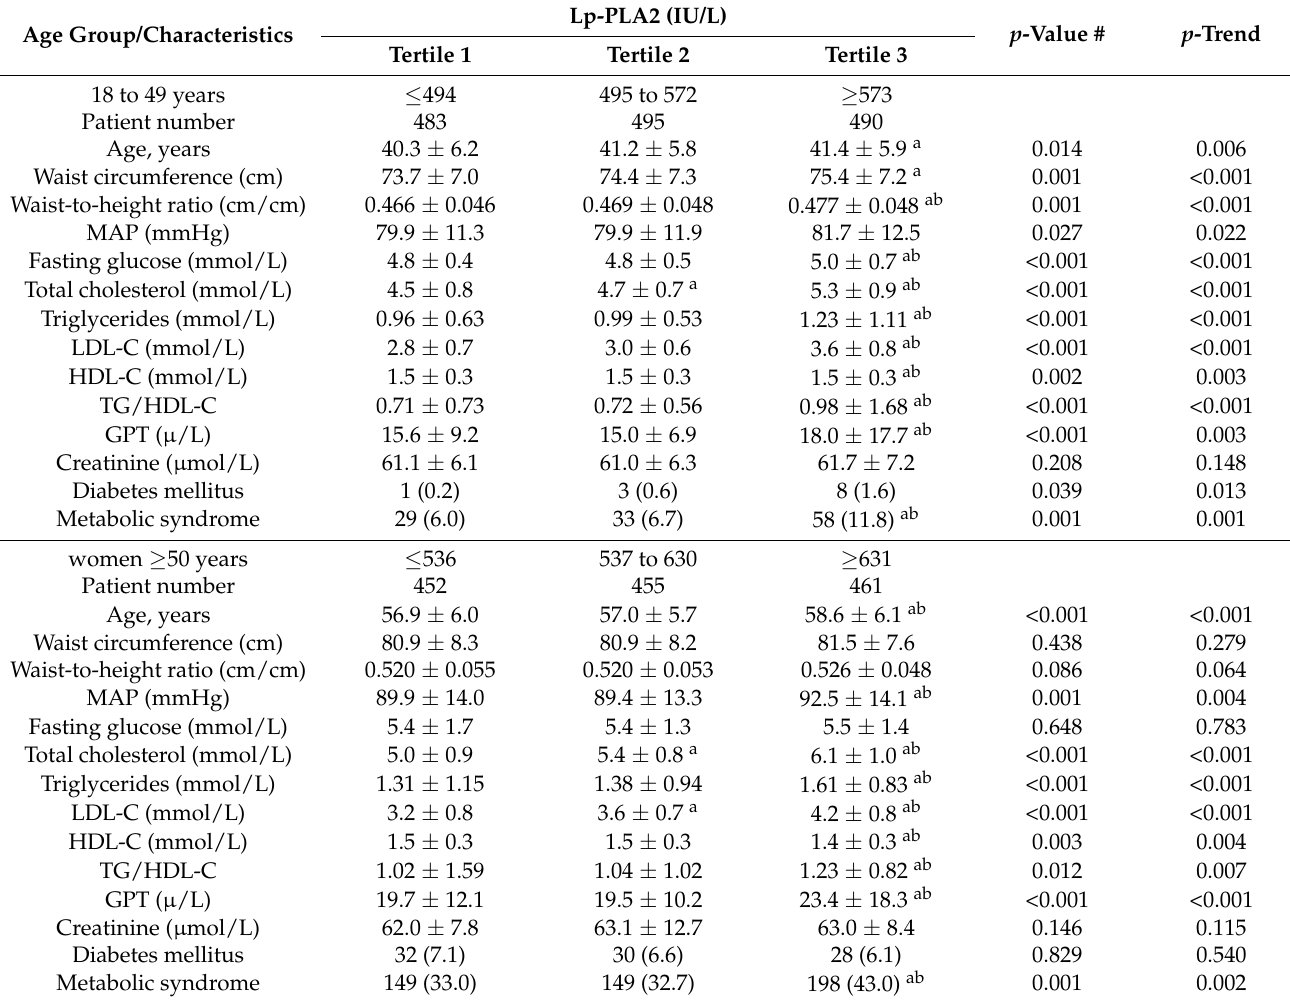
Table 5. Clinical and metabolic characteristics according to Lp-PLA2 level in women.